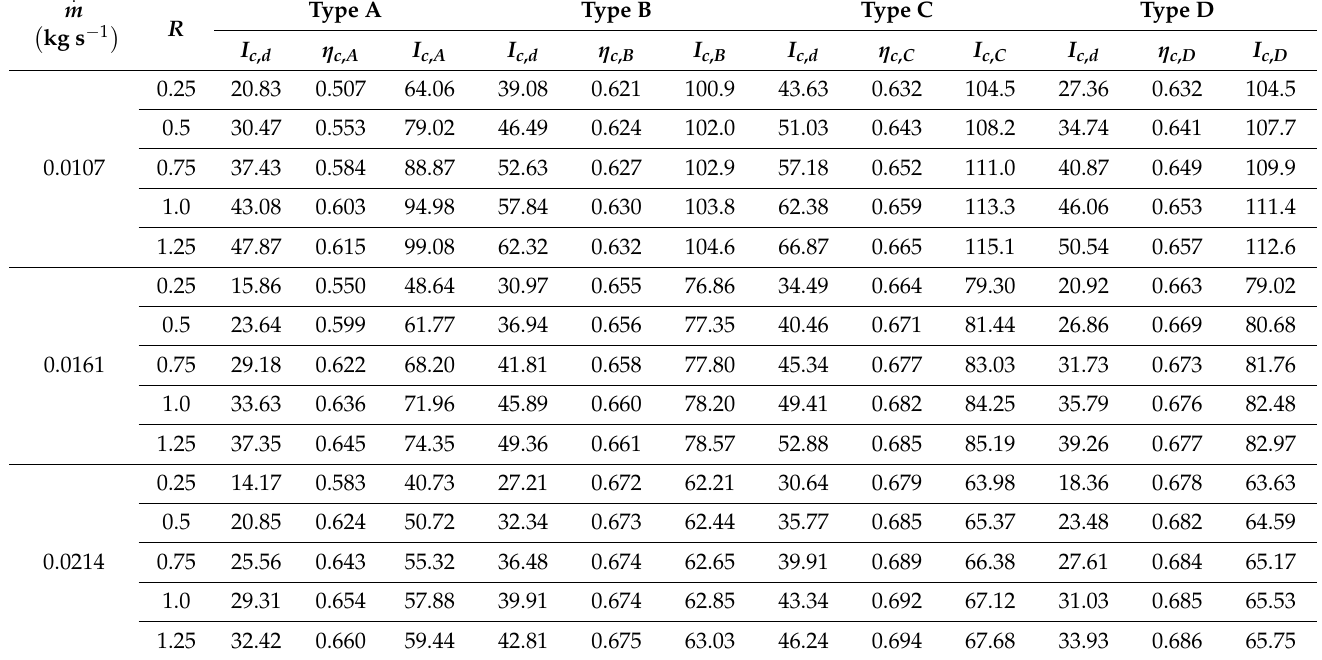
Table 5. Effects of external-recycle types on collector efficiency improvements. ( α = 0.5, β = 0.5 and I 0 = 1100 W m − 2